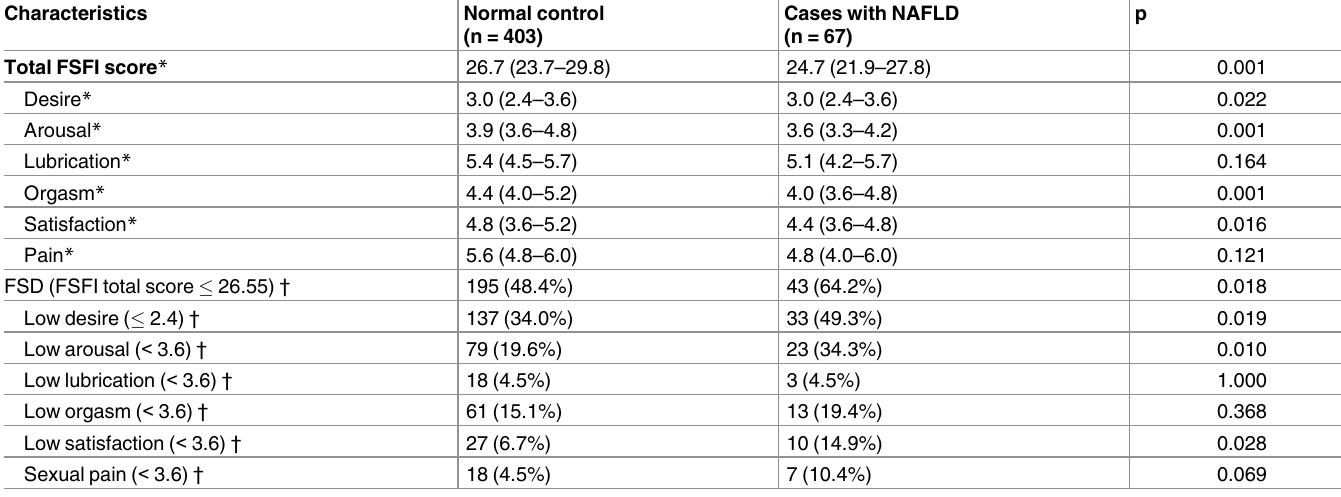
Table 2. Comparison of female sexual function index scores and frequency of female sexual dysfunction according to the presenceor absence of non-alcoholic fatty liver disease.